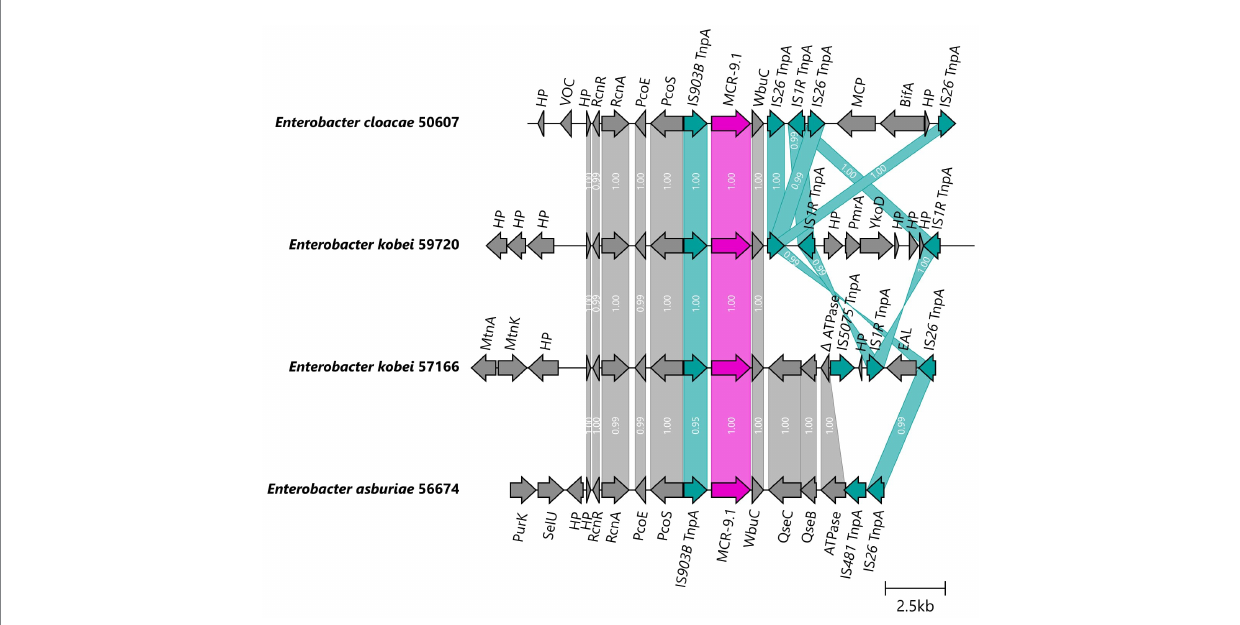
FIGURE 5 Genetic surroundings of mcr-9.1 gene located on chromosomes in Enterobacter . The linearized coding sequences of MCR-9.1 region of four isolates were compared using clinker with identity threshold 90%. The MCR-9.1 (pink) surrounded by mobile genetic elements (turquoise) and other coding sequences (gray) in isolates 50607 and 59720 formed a region corresponding to the mcr-9 region observed in IncHI2/ST1 plasmids. On the other hand, 57166 and 56674 isolates contained downstream sequence similar to the previously described mcr-9 environment in E. asburiae (AP022628). White numbers in links correspond to the similarity of coding